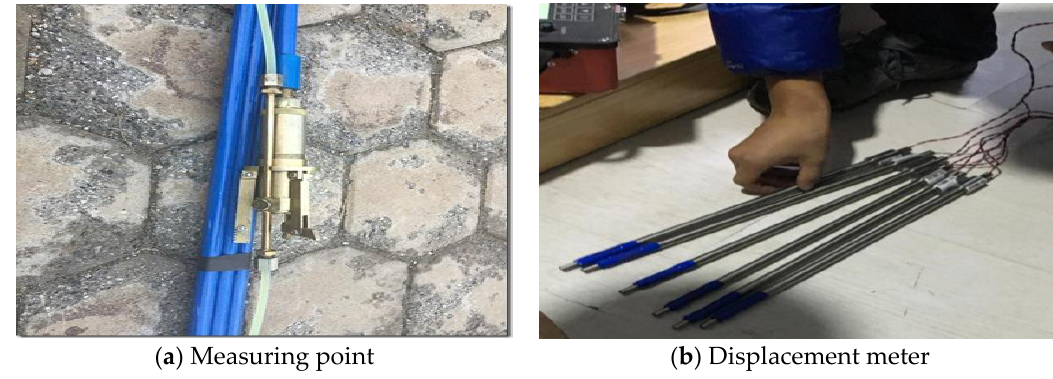
Figure 4. Monitoring instrument.